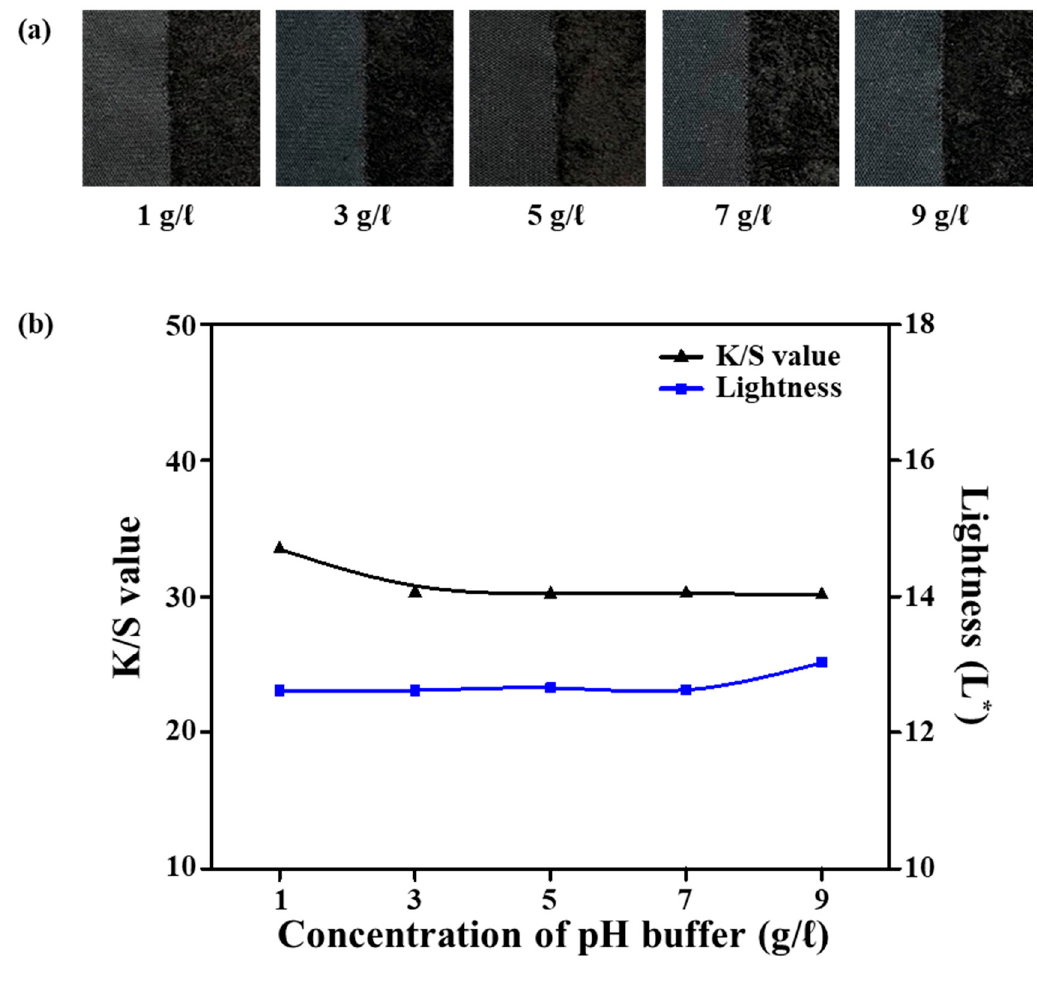
Figure 8. ( a ) Dyed samples. ( b ) K / S and lightness (L*) values according to pH buffer solution concentration (1–9 g/L).